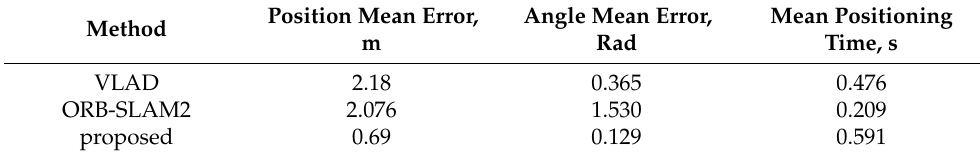
Table 5. Mean error and retrieval time of VLAD and the proposed